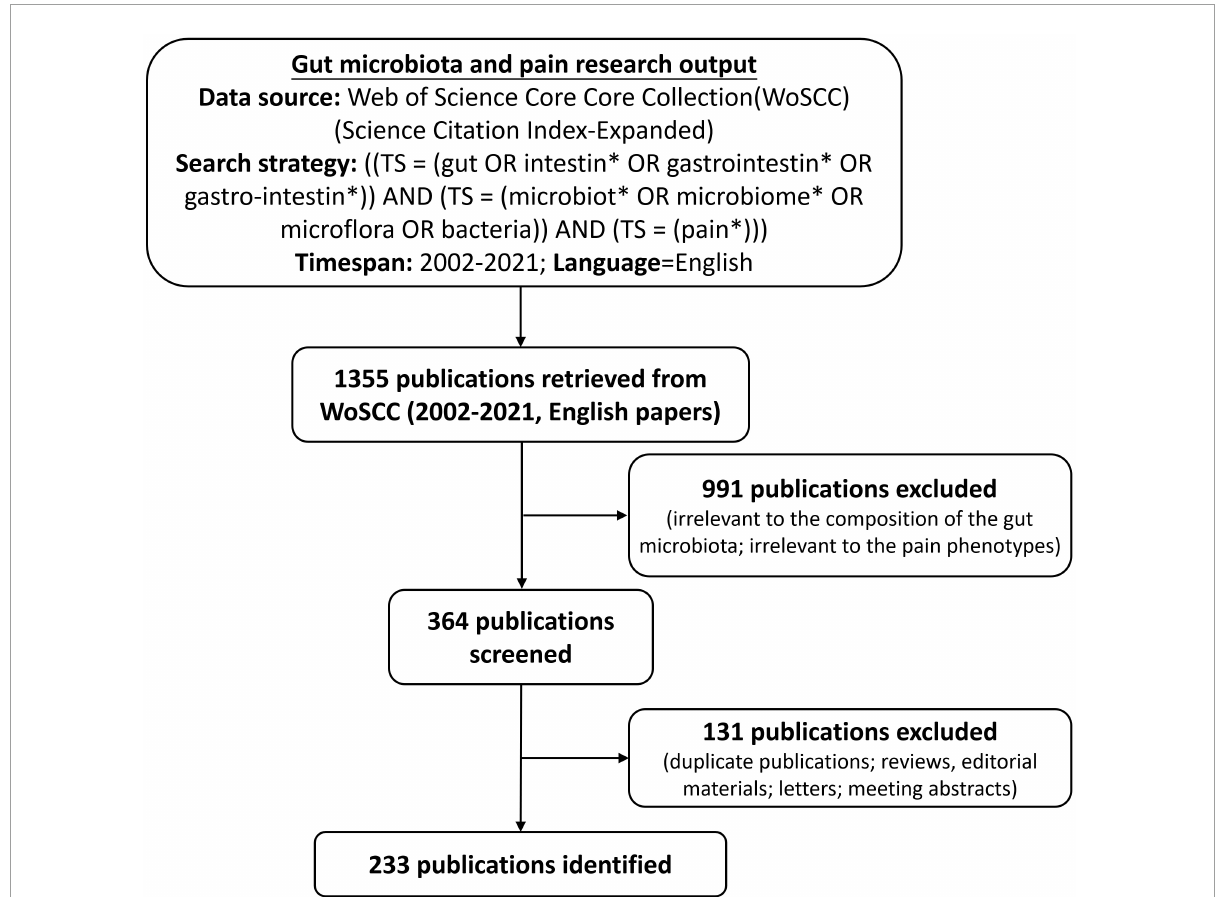
FIGURE1 Flowchart for including and excluding